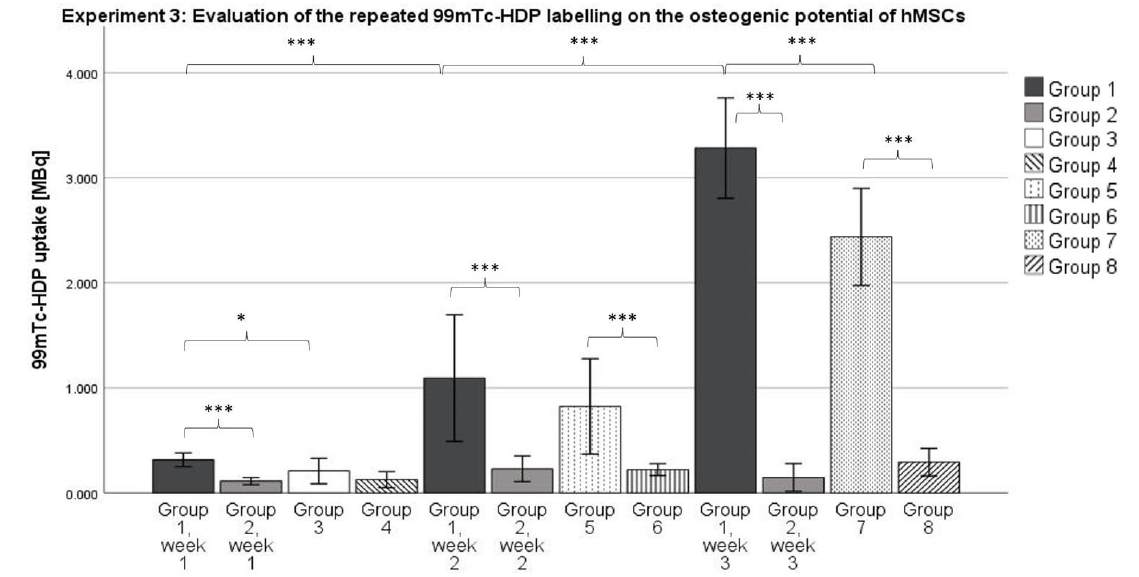
Figure 4. Mean 99m Tc-HDP uptake as measured by the dose calibrator. The error bars show the standard deviation. Stars indicate significant differences between the two groups connected by a bracket. * = significance 𝑝 ≤ 0.05 , *** = significance 𝑝 ≤ 0.001 . n = 6.